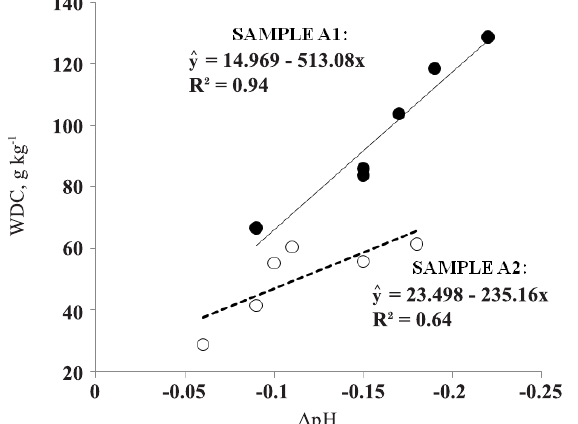
Figure 3. Correlation between water-dispersible clay (WDC) and ΔΔΔΔΔ pH in soil samples A1 (very clayey texture) and A2 (medium texture), after 180 days of incubation in pots kept in a